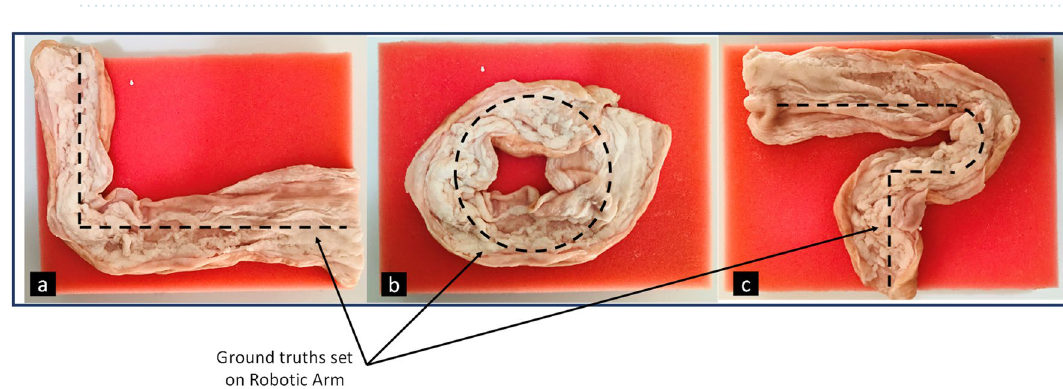
Figure 14. Results of Involuntary motion analysis.